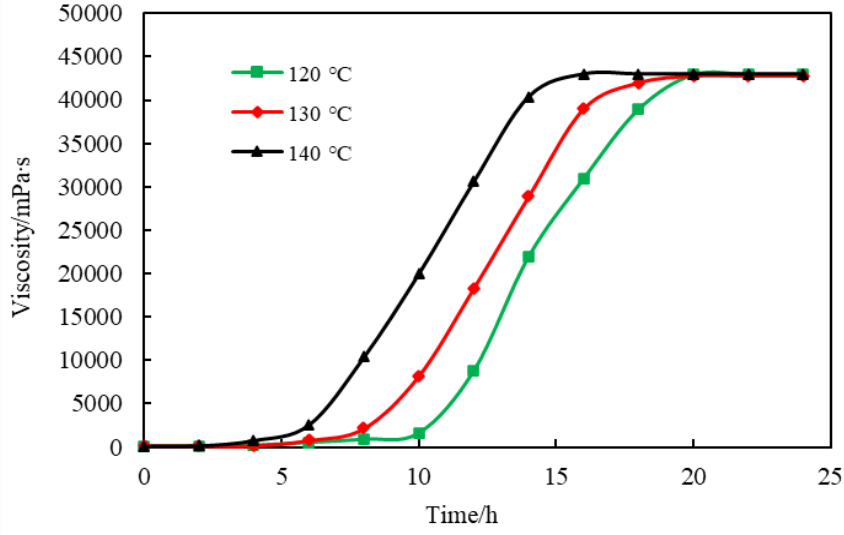
Figure 10. Viscosity–time Curve of Gel.